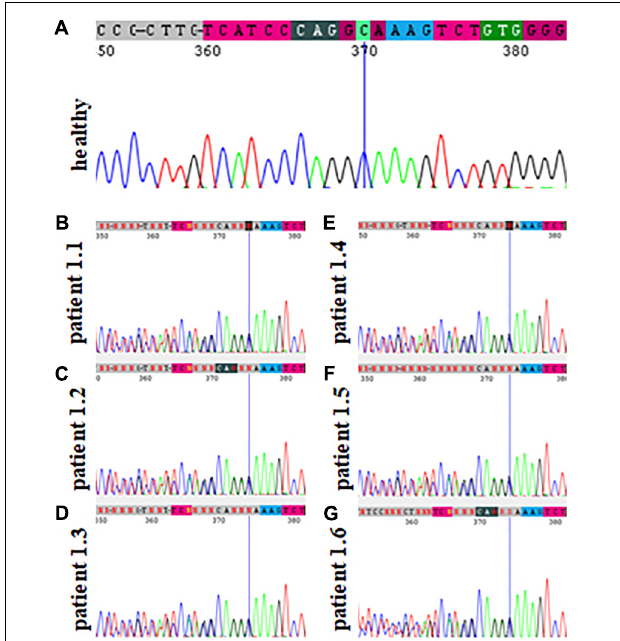
FIGURE 2 | Sanger sequencing results of family 1 showing the absence of the pathogenic variant c.2145_2148dupAAAG p.(Ser717Lys fs *42) within the TCOF1 gene in a healthy family member (A) and its presence in patients affected by Treacher Collins syndrome (B–G) .